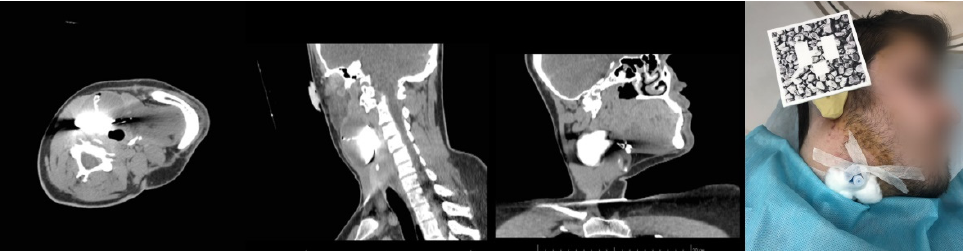
Figure 9. The MSCT of the neck in the patient’s selected position, with intravenous contrast enhancement and cystography ( left ). Venous catheter inserted into the cyst and fixed to the skin, and a PLA splint fixed to a silicon impression of the patient’s ear auricle and auditory passage ( right ).